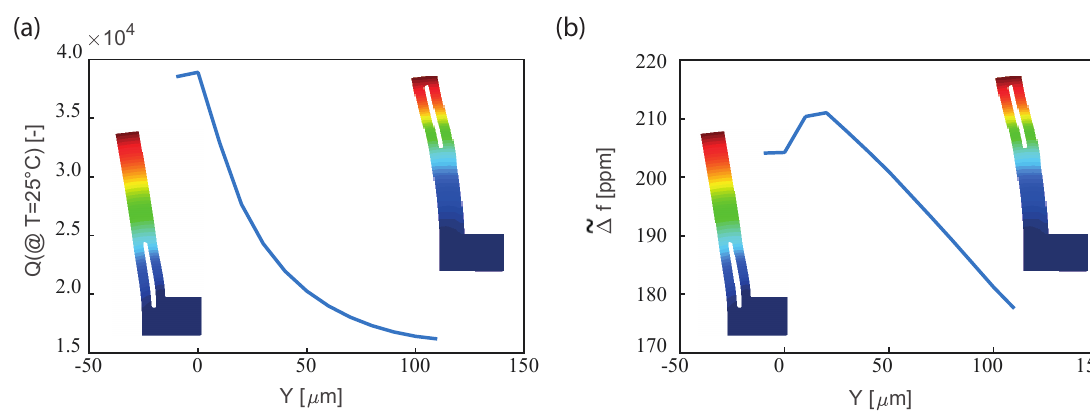
Figure 10. Influence of the hole position on the ( a ) quality factor and ( b ) on the variation of the frequency in the range [ − 35 ◦ C–85 ◦ C]: only the results for the orientation that minimize ˜ ∆ f in the case of the SETF of Figure 2 is reported for the sake of clarity. In this analysis LH = 73 µ m, R = 3 µ m and the other geometric dimensions of Table 2 are